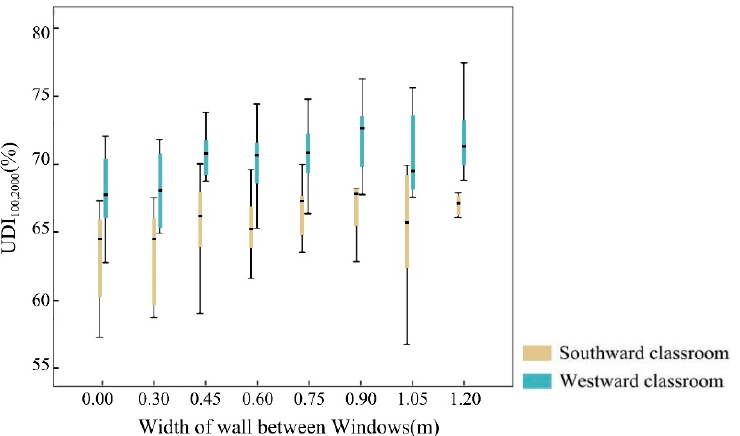
Figure 10. The analysis results of the distribution interval between the width of the wall between windows and the evaluation index.